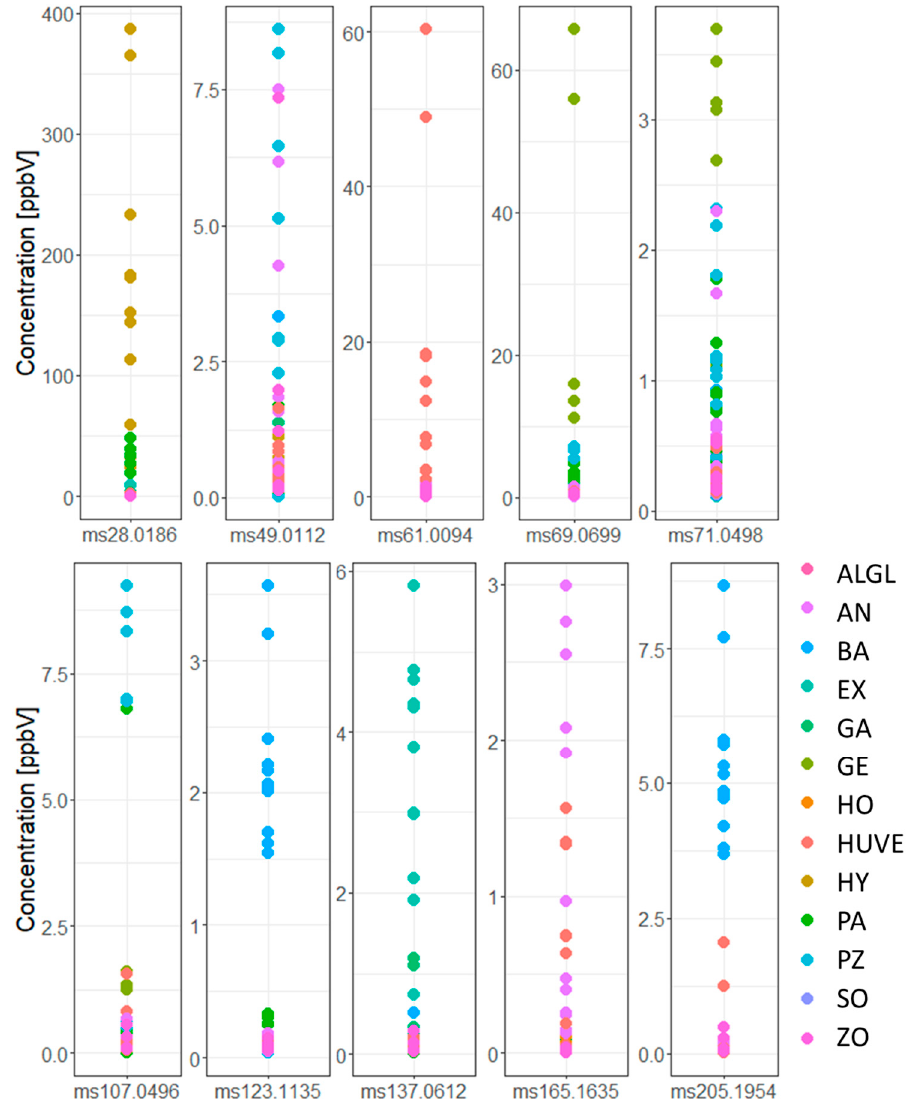
Figure 5. Mass peaks enriched in certain Mortierella s. l. species. Species differ significantly with regards to relative concentrations of these mass peaks according to Kruskal test and ANOVA ( p < 0.05). ALGL = M. alpina/globalpina , AN = M. angusta , BA = M. bainieri , EX = L. exigua , GA = L. gamsii , GE = M. gemmifera , HO = P. horticola , HUVE = P. humilis/verticillata , HY = P. hyalina , PA = E. parvispora , PZ = M. pseudozygospora , SO = M. solitaria , ZO = M. zonata .